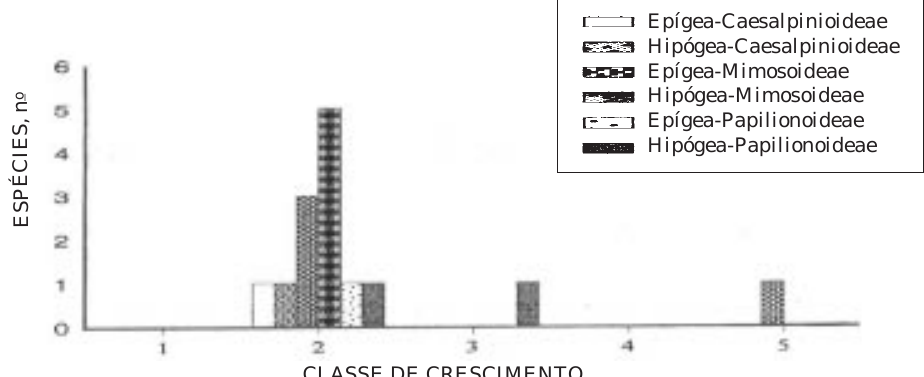
Figura 2. Número de espécies epígeas e hipógeas, oriundas de áreas de terra firme, por classe de crescimento de mudas. Classe 1: inferior ou igual a 10 cm; Classe 2: de 10,1 a 30 cm; Classe 3: de 30,1 a 50 cm; Classe 4: de 50,1 a 70 cm; Classe 5: de 70,1 a 90